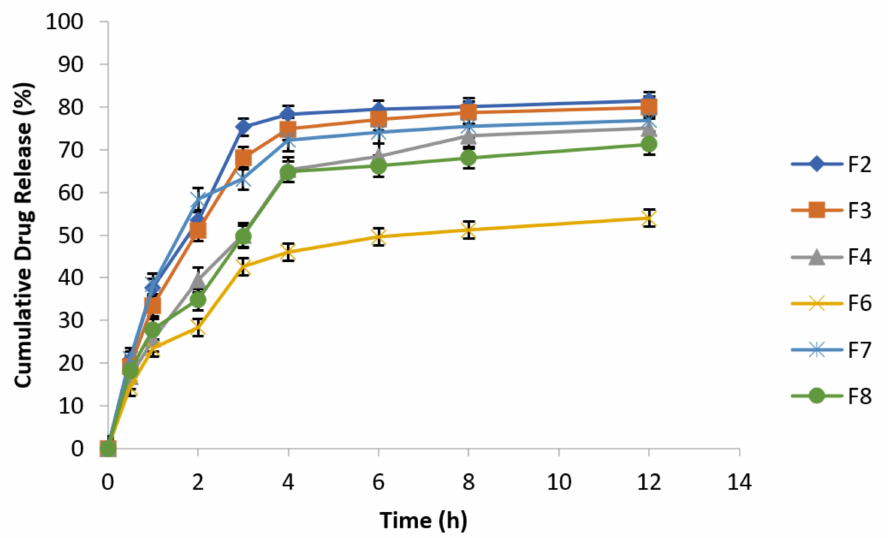
Figure 7. Release behavior of metronidazole effervescent floating tablets at different pH values (n = 3).